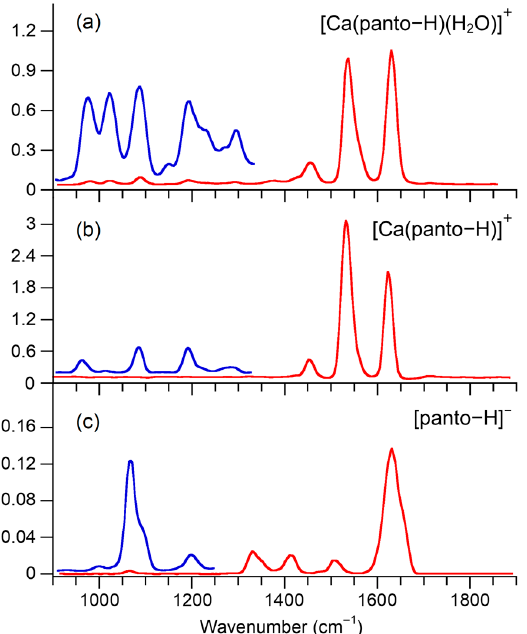
Figure 1. Experimental infrared multiple photon dissociation (IRMPD) spectra of: ( c ) deprotonated pantothenic acid [panto-H] − when the ions are submitted either to 500 ms of free electron laser (FEL) light (blue profile) or to 120 ms using one attenuator (red profile); ( b ) pantothenate calcium complex [Ca(panto-H)] + irradiated with either 1 second of FEL light (blue profile) or with 500 ms using one attenuator (red profile); ( a ) and its monohydrated form [Ca(panto-H)(H 2 O)] + with 500 ms of FEL light and one attenuator (blue profile) or with 250 ms and three attenuators (red profile). In this region, diagnostic absorptions by the peptide backbone, including the Amide I (C = O stretch) and Amide II (NH bend) modes, may be exposed